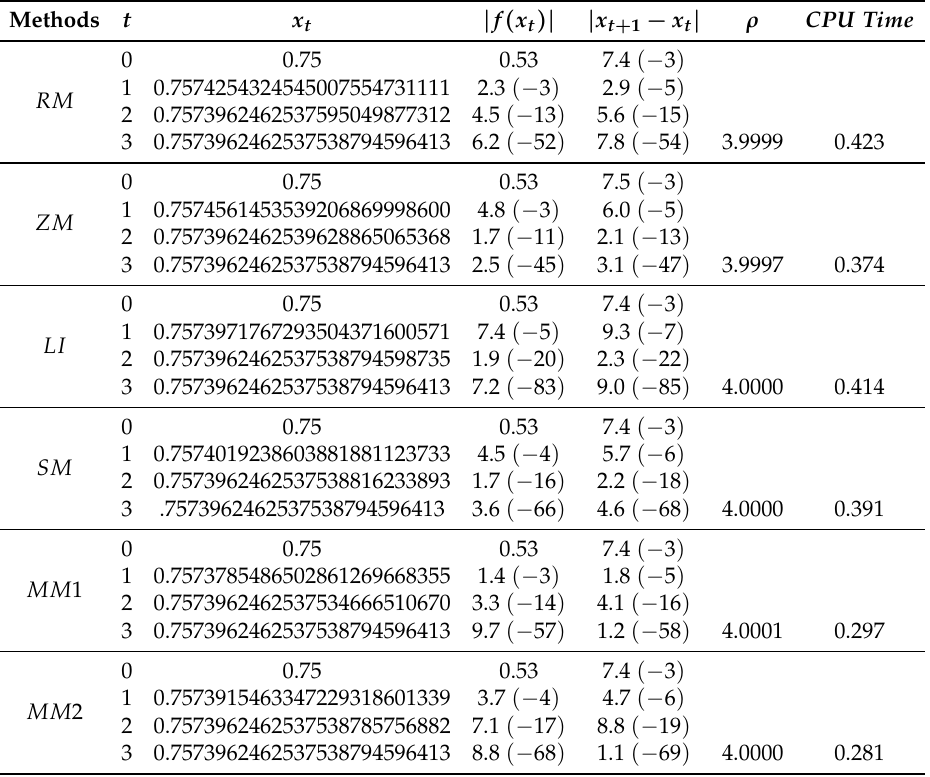
Table 3. Outcomes for comparison by testing schemes on Example